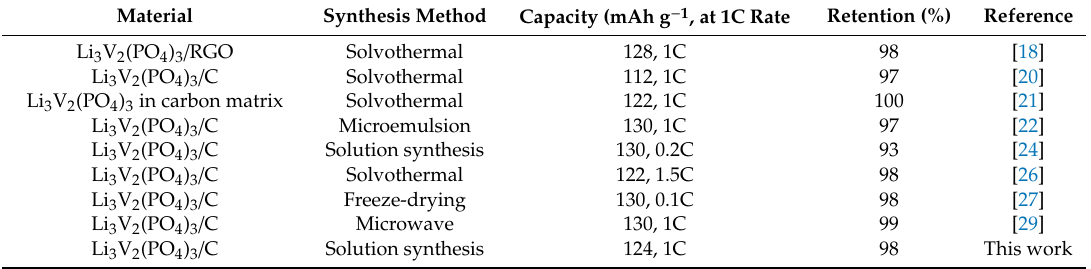
Table 1. Summary of electrochemical properties of Li 3 V 2 (PO 4 ) 3 / C cathode